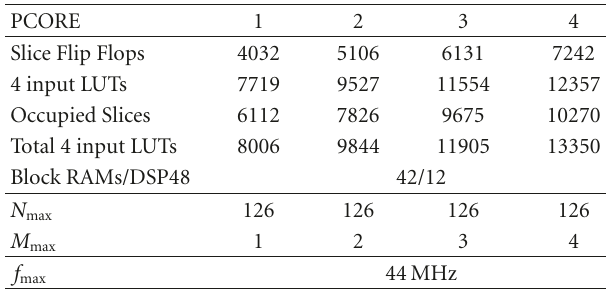
Table 2: RLS lattice coprocessor resources usage in the Xilinx Virtex4 SX35